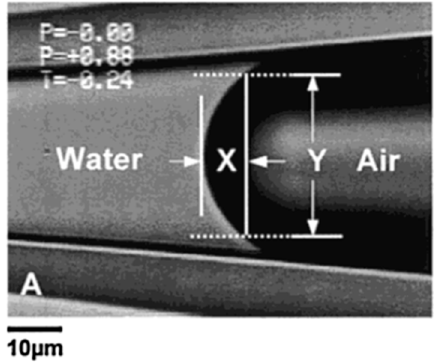
Figure 6. Calculation of radius of curvature R c from the geometry of the surface image. With permission from American Chemical Society [9].